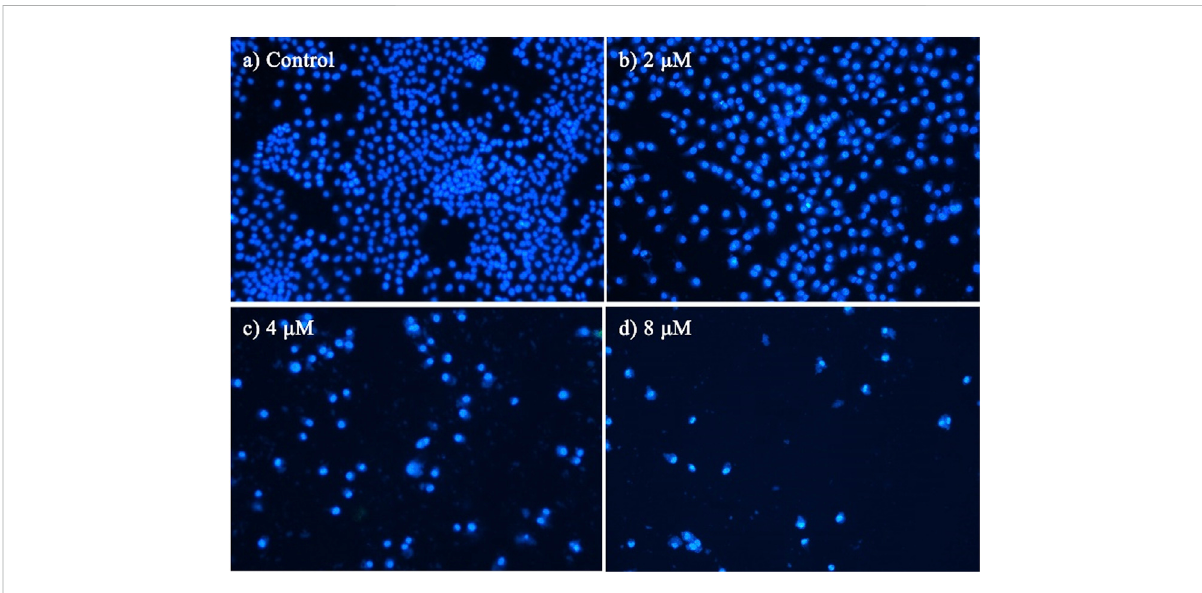
FIGURE 6 Morphological detection of apoptosis using DAPI staining (100×) on MDCK cells treated with BoA2C : (A) control group; (B) 2 μ M; (C) 4 μ M; (D) 8 μ